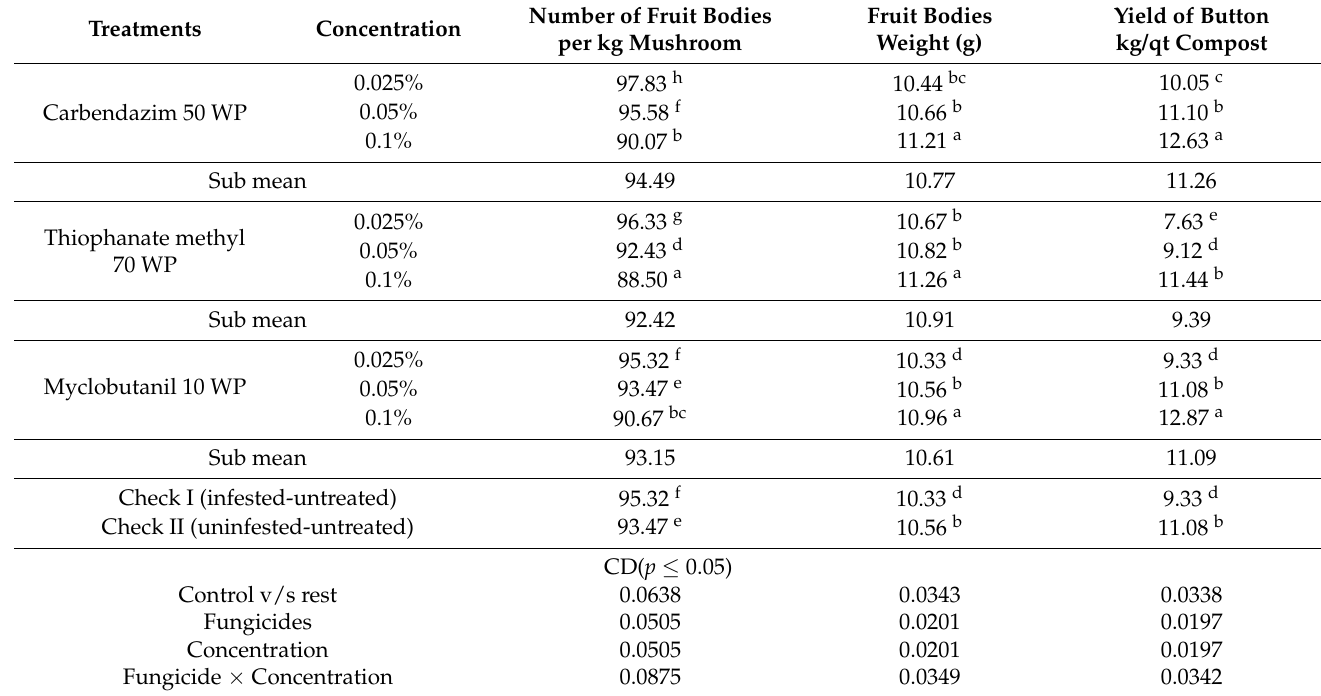
Table 10. Effect of systemic fungicides on T. harzianum infested casing pooled during spring 2017 and 2018 on the number of fruit bodies per kg mushroom, fruit bodies weight (g) and yield of button (kg/quintal